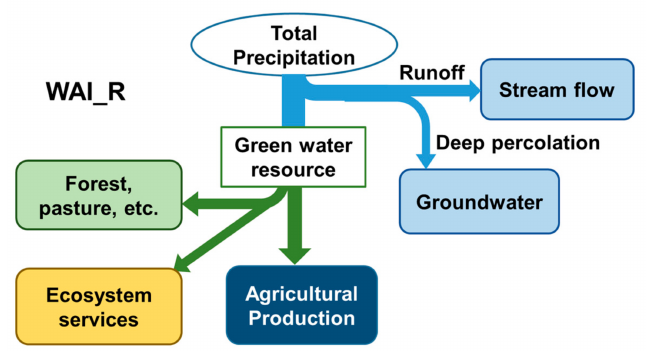
Figure 1. Conceptual diagram for the water availability assessment. Total precipitation is divided into green water resources (effective rain) and blue water resources (runoff, deep percolation to aquifers). This approach quantifies the water resource balance aggregated at the regional level (e.g., county) without considering water availability related to specific fields within each